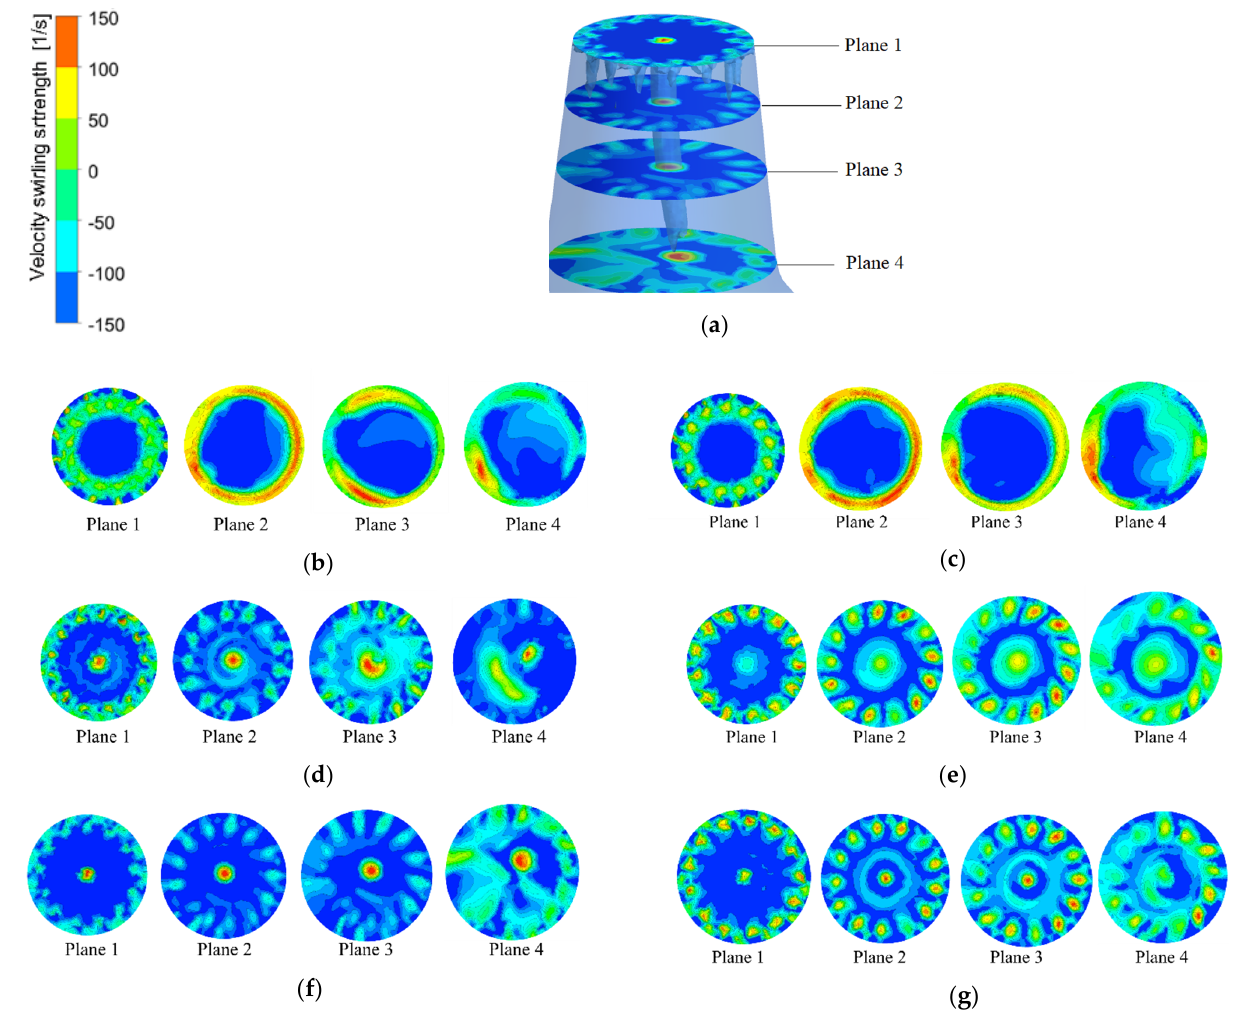
Figure 8. Vorticity and vortex ropes at various sections of the draft tube. ( a ) Local diagram, ( b ) OP1, ( c ) OP2, ( d ) OP3, ( e ) OP4, ( f ) OP5, and ( g ) OP6.